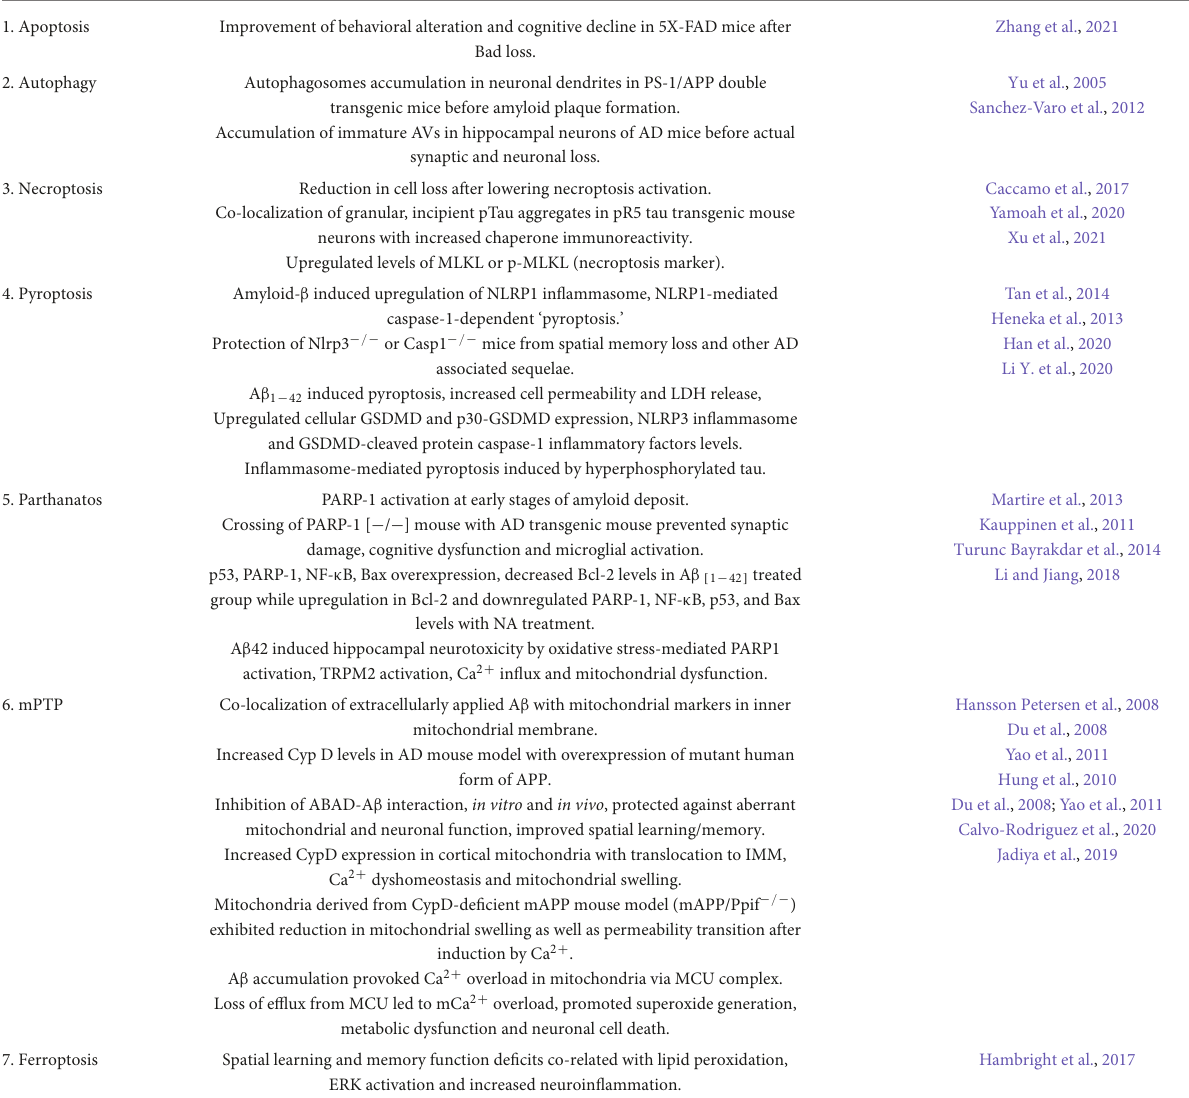
TABLE 2 Cell death pathways responsible for neuronal death in experimental studies on AD models with evidence from various studies. Experimental studies in AD